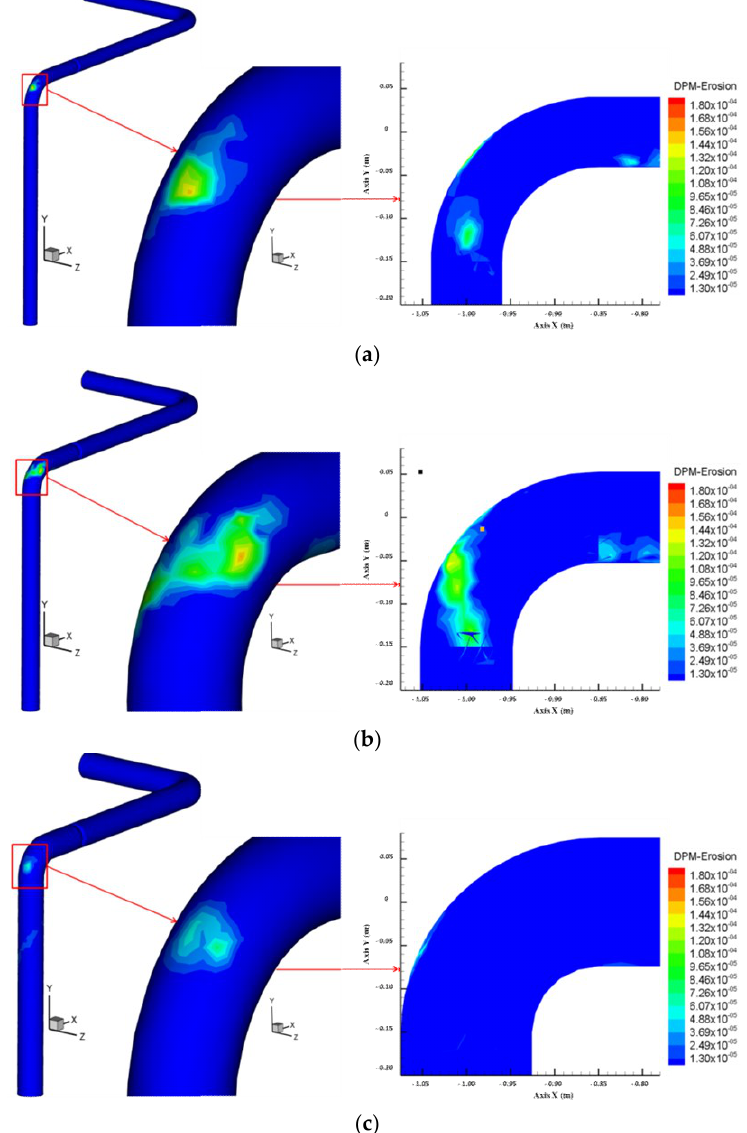
Figure 14. Maximum erosion rate contours of gas–solid two-phase flow pipeline for different pipe diameters with 50% of the throttle valve opening. ( a ) DN80; ( b ) DN100; ( c ) DN150.